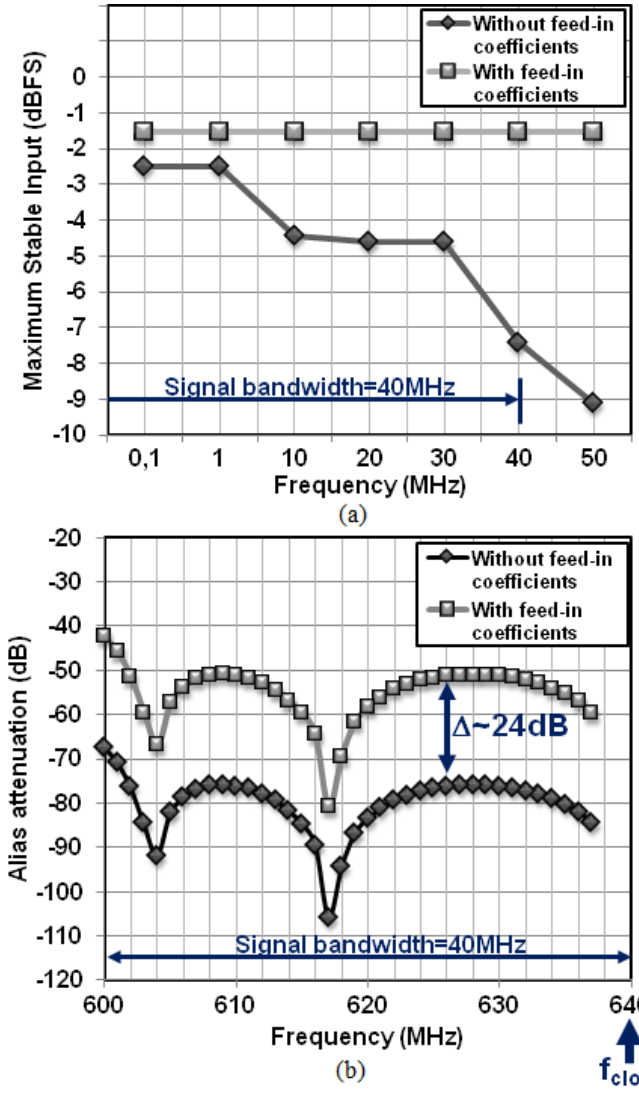
Figure 3. Feed-in coefficients effect on ( a ) the maximum stable input amplitude, ( b ) the inherent anti-alias filter transfer function. (The attenuation curves are obtained with transient simulations followed by a frequency